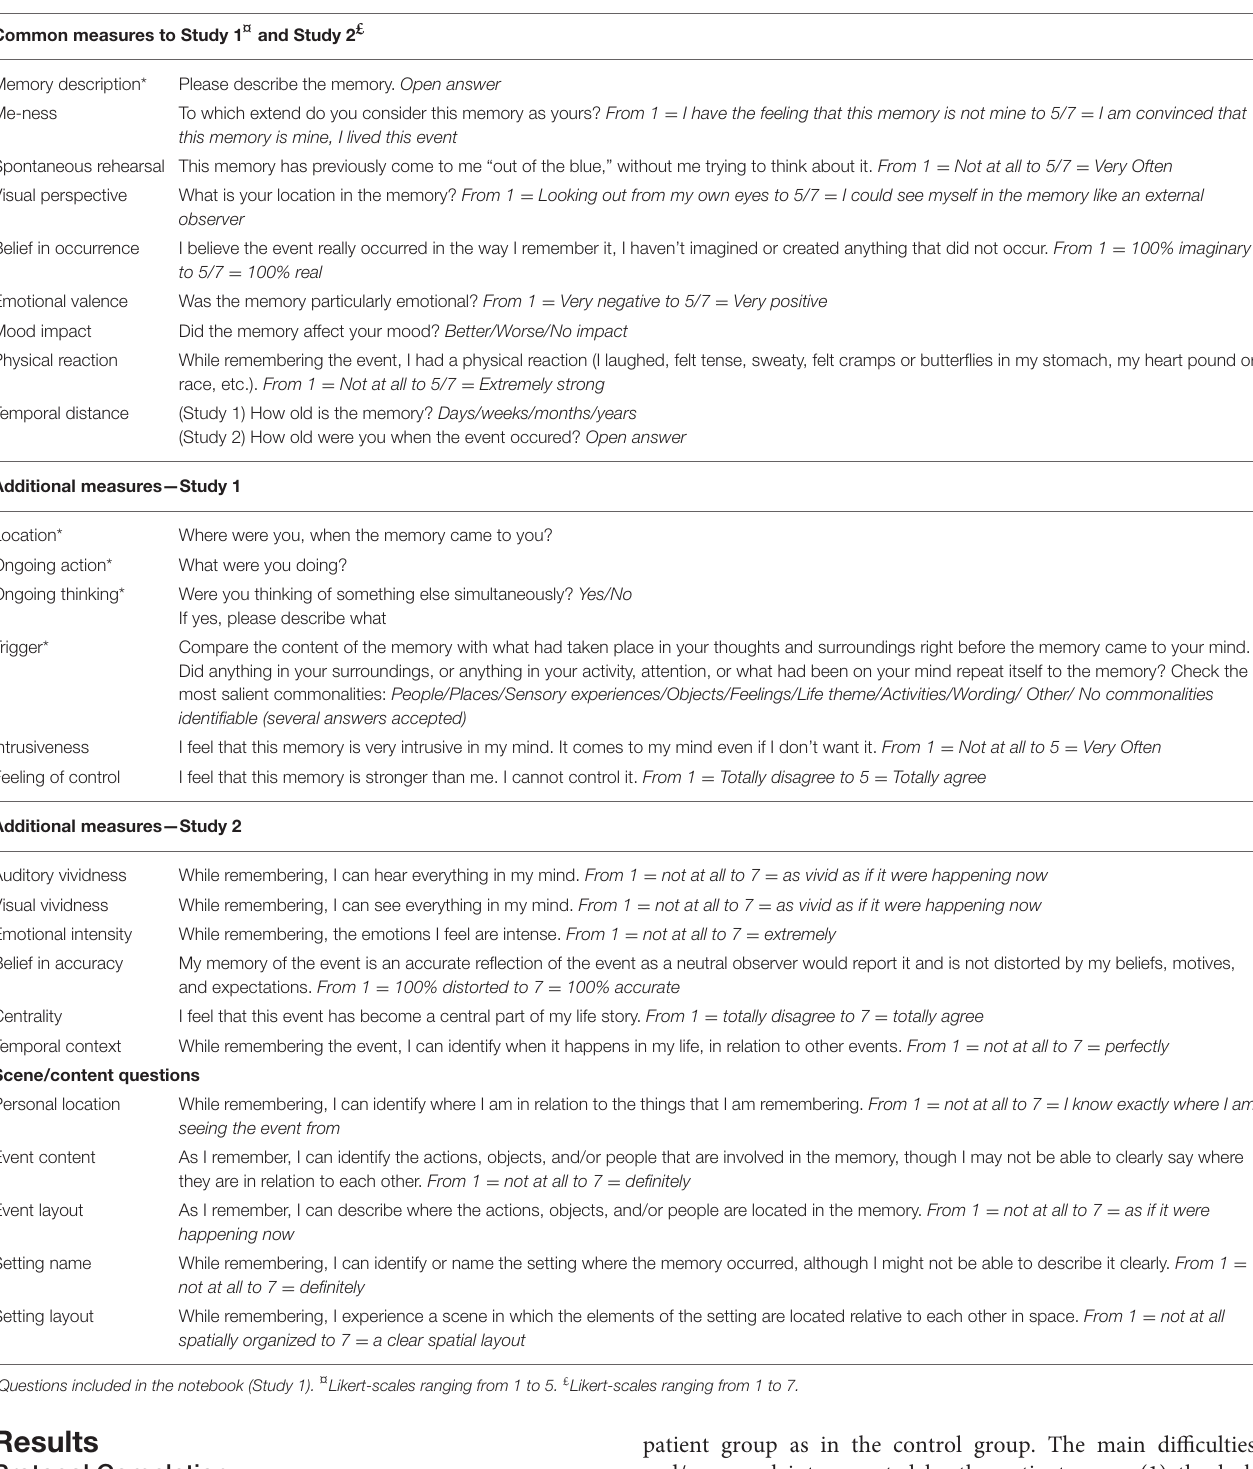
TABLE 2 | Questions included in the memory